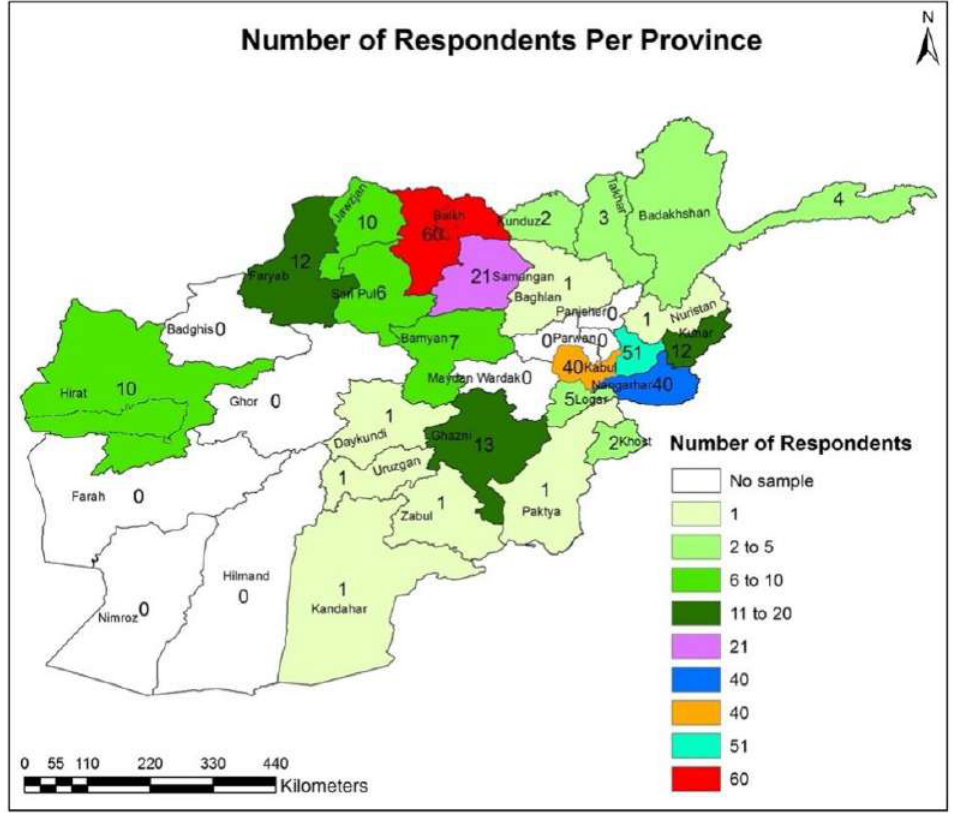
Figure 1: Province-wid e Distribution of Respondents (Source: Afghanistan‟s province -level shapefile has been used from the Texas GeoData portal by The University of Texas at Austin (2020). Dr. Mehebub Sahana in ArcGIS software has prepared the